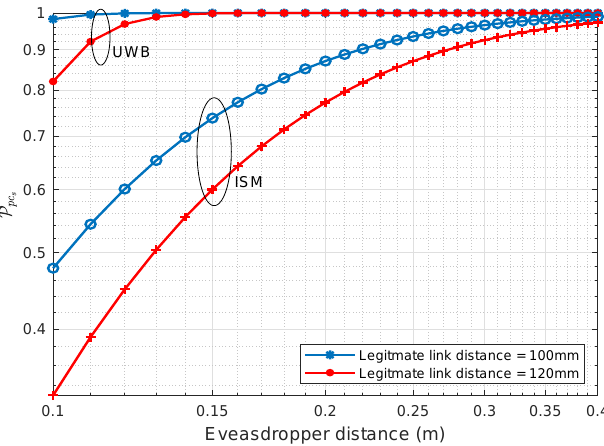
Figure 17. P pc regarding legitimate link SNR. s